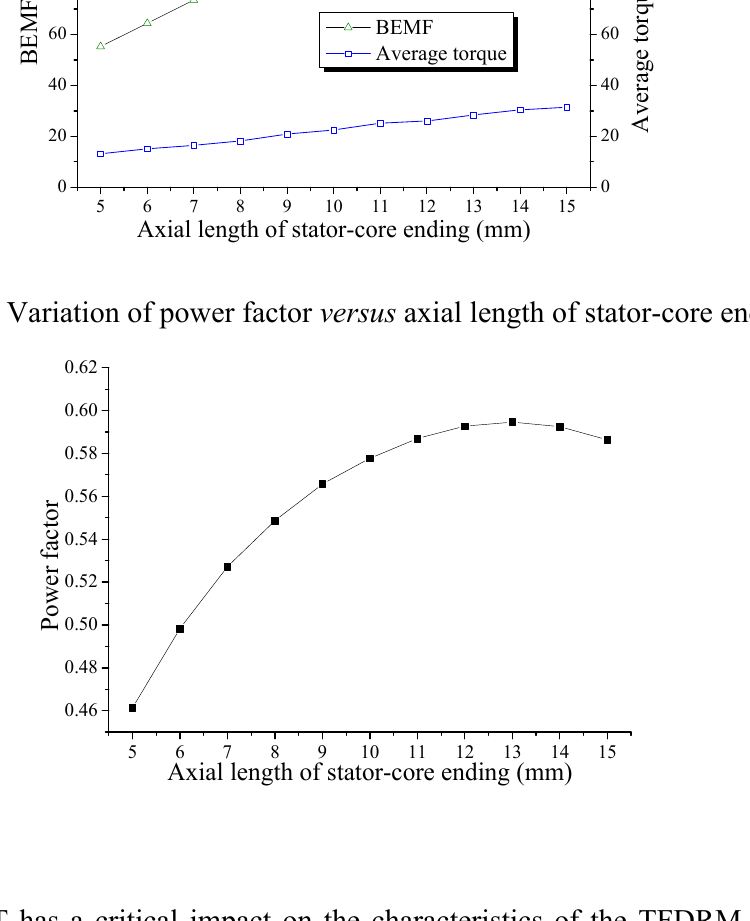
Axial length of stator-core ending